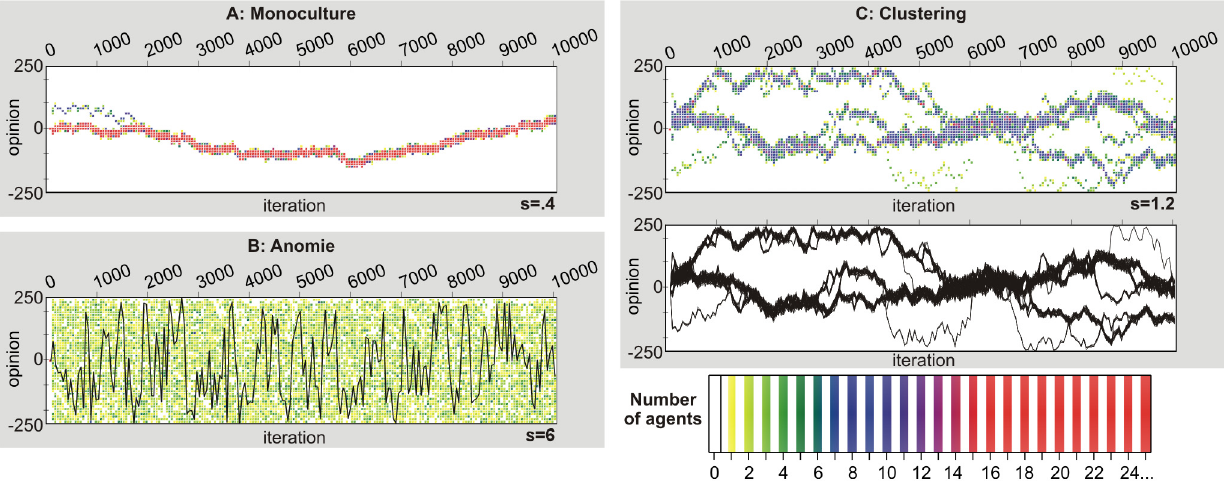
Figure 2. Opinion trajectories of three representative simulation runs with 100 agents generated by the Durkheimian model. In all three runs, the opinions are restricted to values between 2 250 and 250, and all agents hold the same opinion initially ( o i (0) ~ 0 for all i ). In all runs, we assume the same social influence range A ~ 2 , but vary the strength s of the disintegrating force. (A) Monoculture, resulting in the case of a weak disintegrating force ( s ~ 0 : 4 ). Agents do not hold perfectly identical opinions, but the variance is low. We studied dynamics over 10.000 iterations (Each iteration consists of N simulation events t .). (B) Anomie (i.e. extreme individualism), generated by a very strong disintegrating force ( s ~ 6 ). Agents spread over the complete opinion scale. The black line represents the time-dependent opinion of a single, randomly picked agent, showing significant opinion changes over time, which is in contrast to the collective opinion formation dynamics found in the monocultural and pluralistic cases (A) and (B). (C) For a moderate disintegrating force ( s ~ 1 : 2 ), the population quickly disintegrates into clusters. As long as these clusters are small, they are metastable. However, clusters perform random walks and can merge (e.g. around iteration 5500). As the disintegrating force grows with the size of a cluster, big clusters eventually split up into subclusters (e.g. around iteration 7000). The additional graph, in which each agent’s opinion trajectory is represented by a solid black line, is an alternative visualization of the simulation run with s ~ 1 : 2 . It shows that the composition of clusters persists over long time